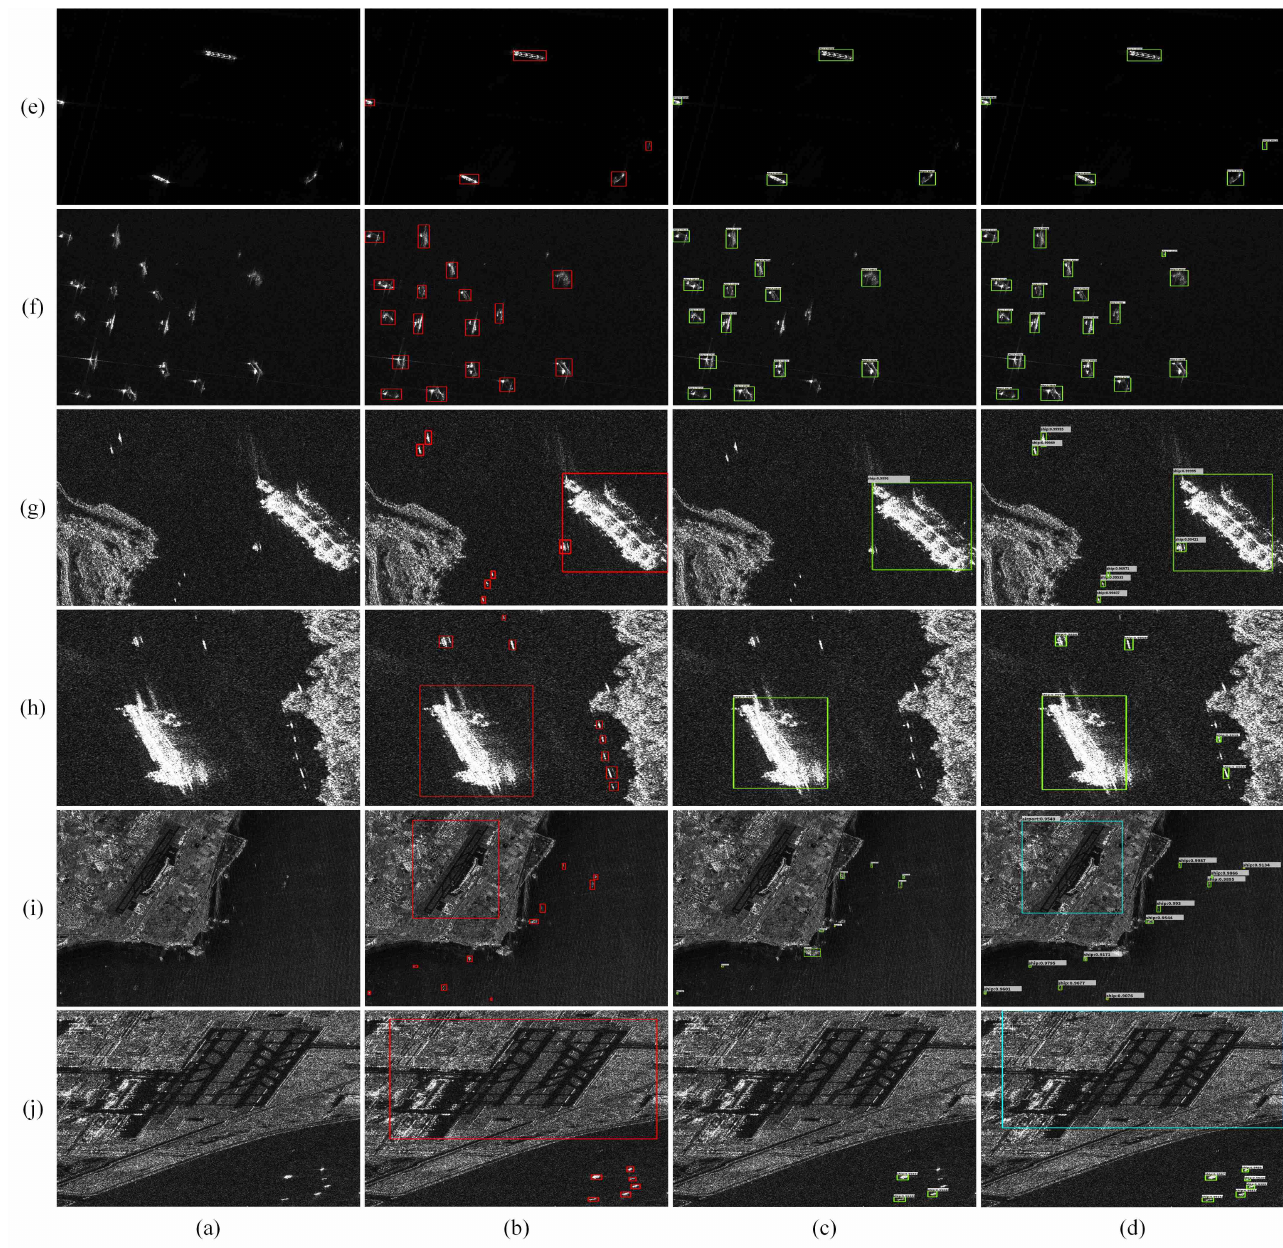
Figure 12. Effect of UltraHi-PrNet. ( a ) is the initial image. ( b ) is the image with the truth box. ( c ) is the result image of the method without the scale transfer layer and scale extension layer. ( d ) is the result image of UltraHi-PrNet. As shown in the figure, ( e , f ) are simple scenes, and ( g – j ) are complex